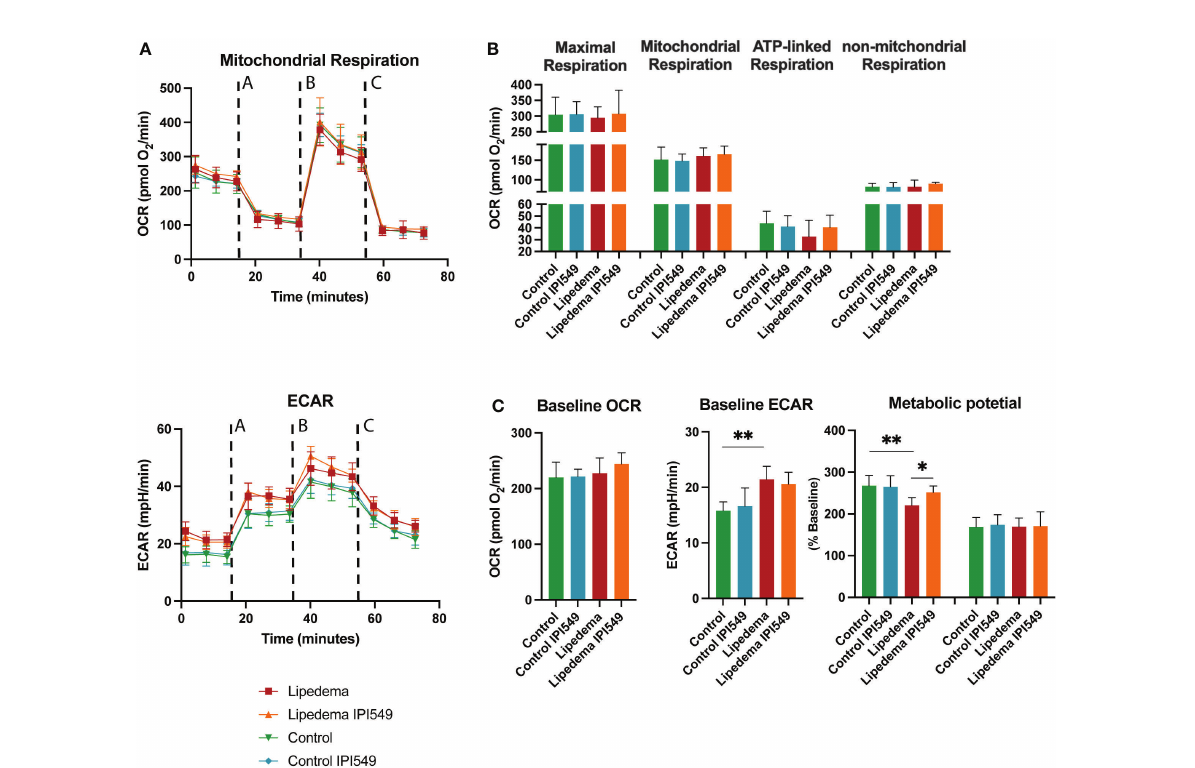
FIGURE 7 Oxygen consumption rates of differentiated ADSCs with conditioned medium of IPI-549 treated and untreated SVF of lipedema and control patients. (A) Evaluation of the oxygen consumption rate (OCR) and extracellular acidi fi cation rate (ECAR) changes in response to